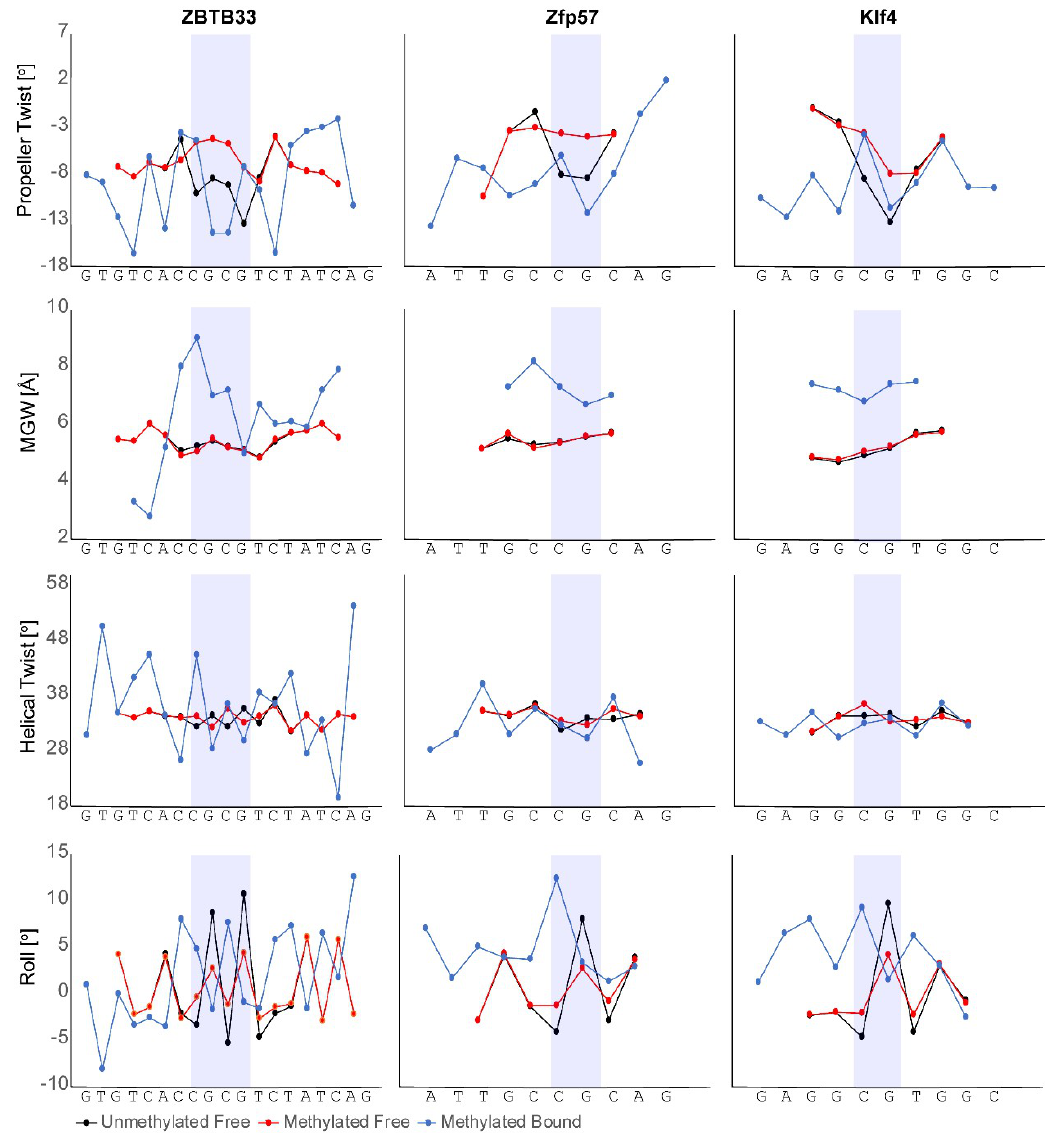
Figure 3. DNA shape analyses for the DNA targets of ZBTB33, Zfp57, and Klf4 used for crystallography in their free unmodified CpG (black), free methyl-CpG (red), and methyl-CpG protein complexed (blue) forms. The blue rectangles are centered on the core CpG dinucleotides.